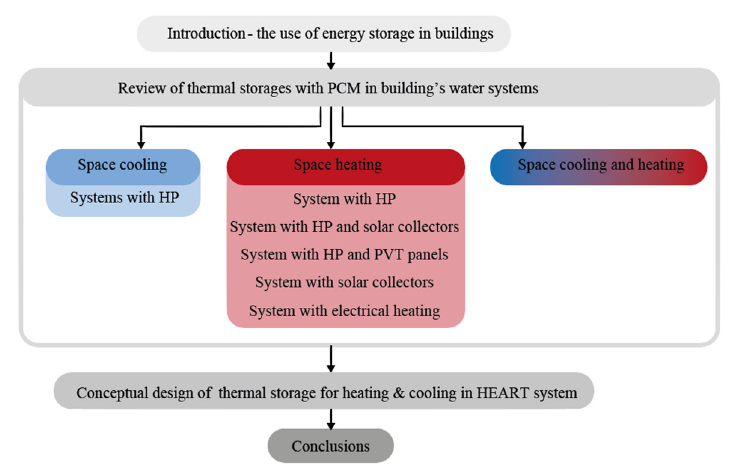
Figure 1. Particular sections of the review.